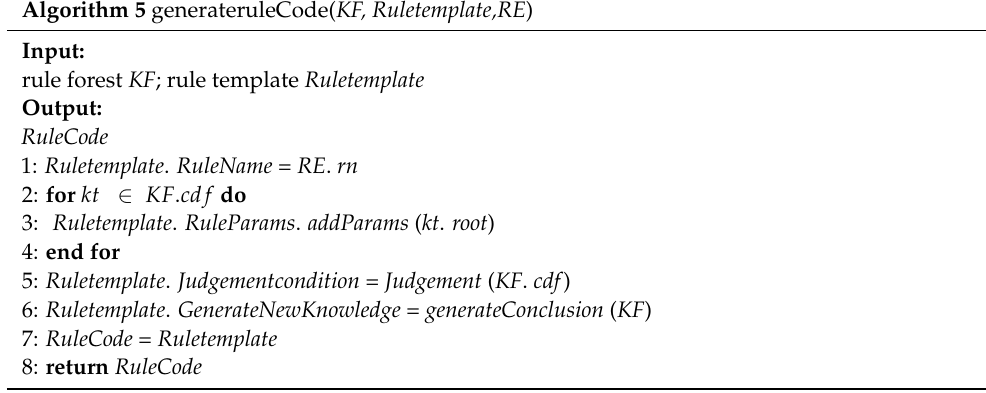
Algorithm 5 generateruleCode( KF, Ruletemplate,RE